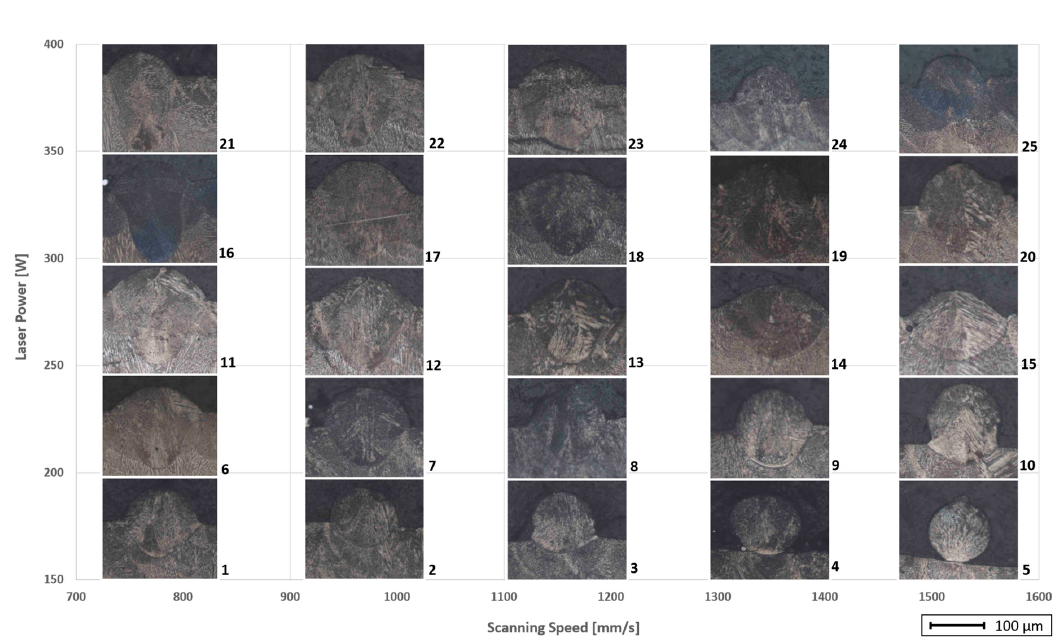
Figure 15. Melt pool shape at various levels of laser power and scanning speed (number in black indicate the sample).